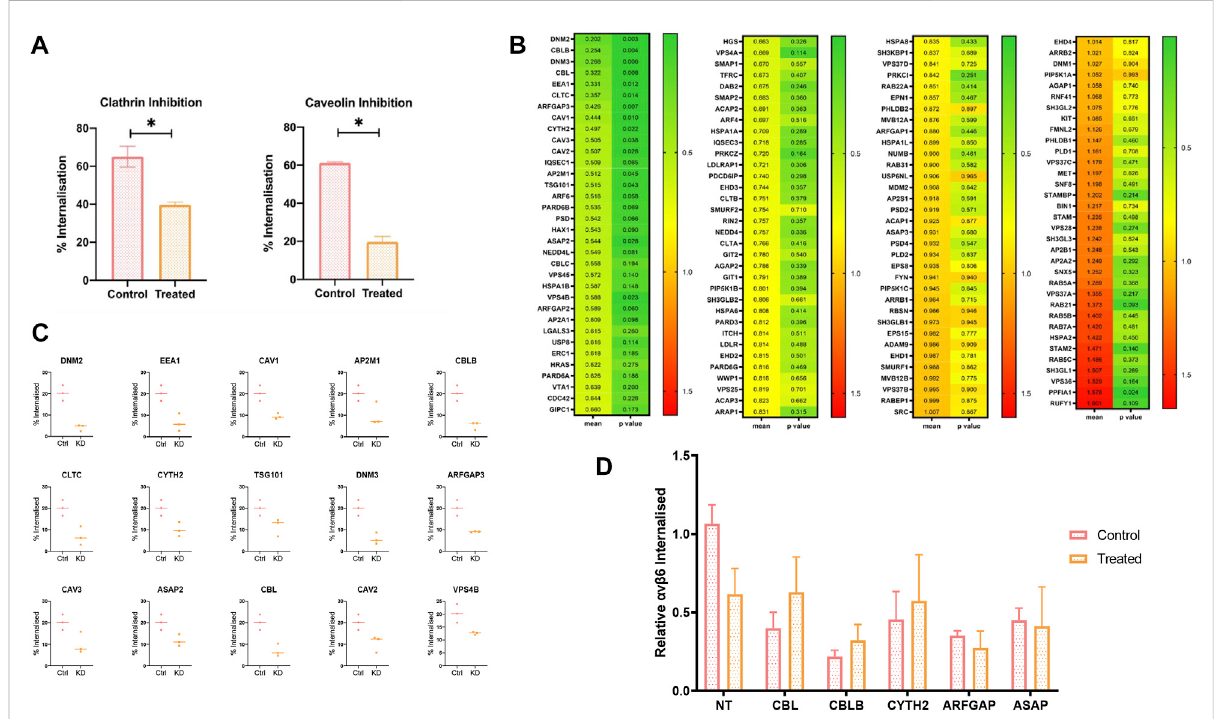
FIGURE 3 An siRNA screen to determine molecular regulators of A20FMDV2- α v β 6 endocytosis. (A) C76 cells were pre-treated with either 2 ug/ml of Chlorpromazine (clathrin inhibitor) or 10 ug/ml of Filipin (Caveolin inhibitor) before performing A20FMDV2 internalisation assay as described. Both Clathrin and Caveolin inhibition resulted in a signi fi cant decrease ( p < 0.05) in the rate of internalization (65 ± 9.5% to 39 ± 2.5% and 61 ± 0.8% to 19.7±3.9%,respectively)( n =3). (B) Cherry-pickedsiRNAlibraryfeaturing140genepoolswastransfectedintoC76cells.72 hposttransfection an internalisation assay by fl ow cytometry was performed as previously described. The fi rst column of the heat map represents the relative internalisation compared to the non-targeting, with green representing a decrease and red indicating an increase. The second column represents the p -value,with green representing alower p value,and redahigher p value. Datarepresents meanvalues ( n =4). (C) Fifteen genesareshown from the fl owcytometryscreenwhichsigni fi cantlyreducedtherateof α v β 6-A02FMDV2endocytosisintoC76cells( p < 0.05).Datarepresentsmean±SD. p < 0.05, as determined by student ’ s t -test. (D) C76 cells were transfected with 50 mM of the indicated siRNA smartpool, 72 h later the cells were either treated with Clathrin inhibitor or vehicle control, and an internalisation assay performed as previously described using A20FMDV2.